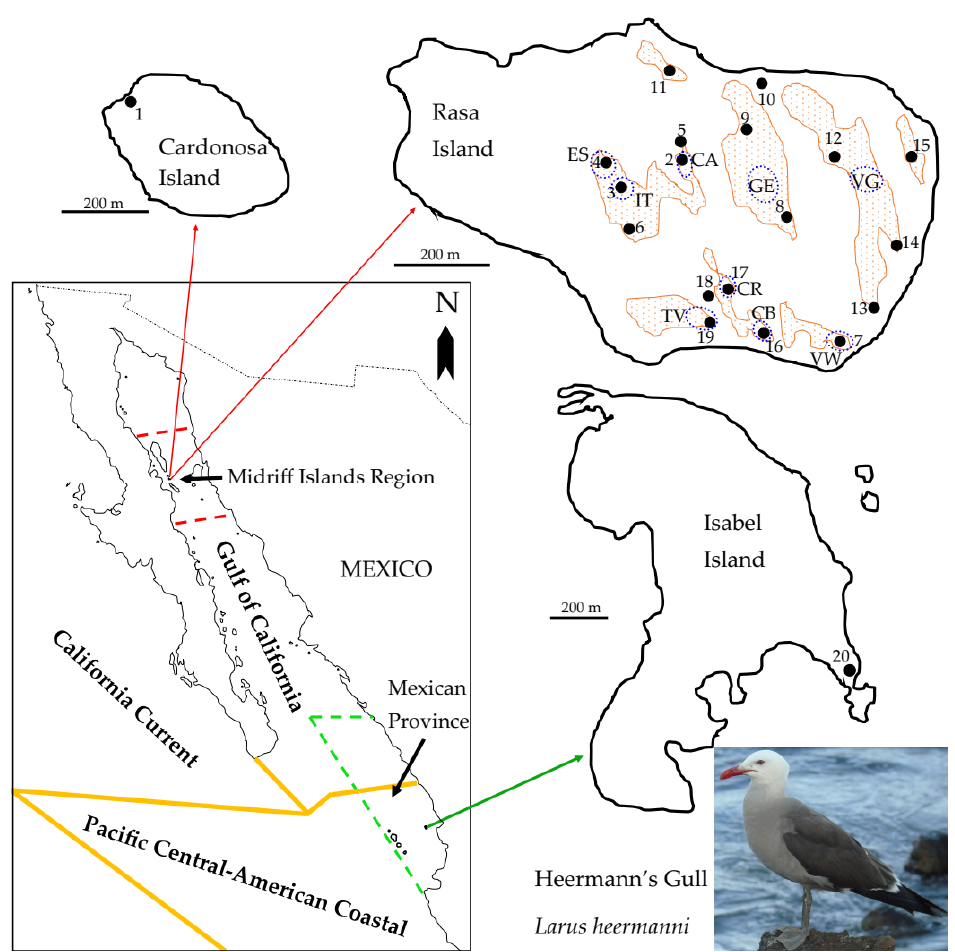
Figure 1. Heermann’s Gull banding and monitoring were carried on Rasa Island between 1984 and 2013. Fledglings (blue dotted lines, n = 28,000; Table S1) were banded within their natal valleys (Orange continuous lines: ES, Valle del Estero; IT, Vallecito del Estero; CA, Valle de la Casita; GE, Gran Estación; VG, Valle de los Gallitos; TV, Tapete Verde; CR, Casitas Viejas Arriba; CB, Casitas Viejas Abajo; and VW, Valle de la W). Later, they were recaptured breeding as adults ( n = 998). Mitochondrial cytochrome b sequences (1033 bp) were obtained from 296 gulls in nests from twenty locations distributed on Cardonosa, Rasa and Isabel Islands (dark circles, numbered from 1 to 20). Map modified from Mellink [51], showing the classic regions Midriff Islands Region and Mexican Province [54], as well as the Large Marine Ecosystems [53]. Photo credit: Misael Mancilla.